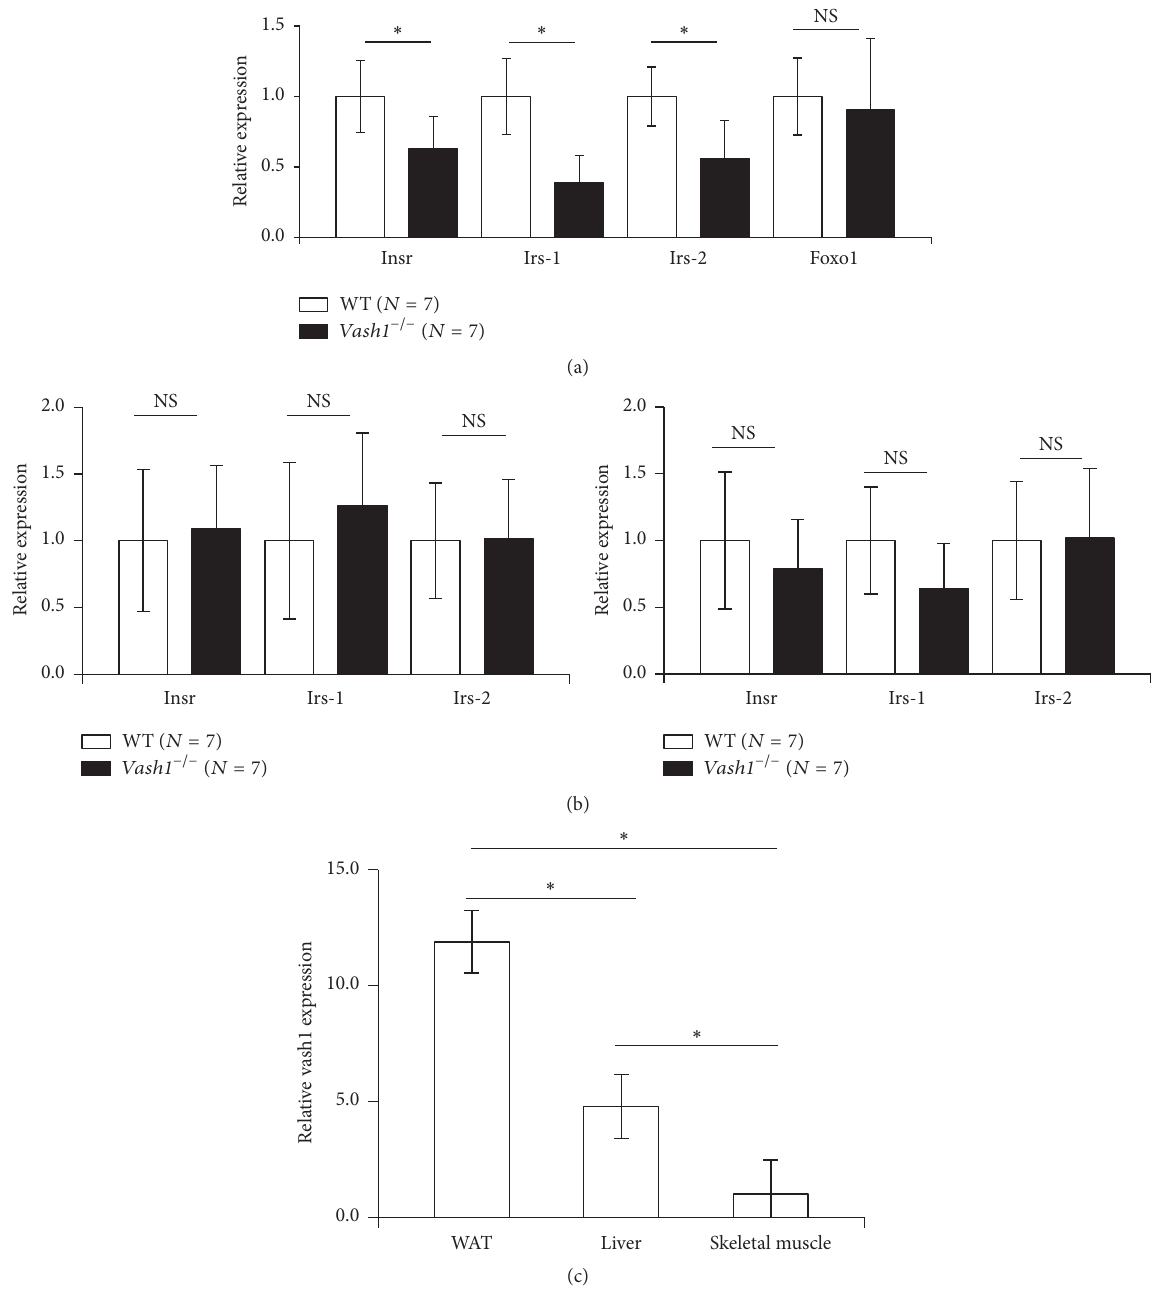
Figure 3: Downregulation of insr, irs-1, and irs-2 in WAT of young vash1 −/− mice. (a) Total RNA was isolated from the WAT of WT and vash1 −/− young male mice, and the expression of insr, irs-1, irs-2, and Foxo1 was compared between WT and vash1 −/− mice. (b) Total RNA was isolated from skeletal muscle or liver of WT and vash1 −/− young male mice; and the expression of insr, irs-1, and irs-2 was compared between WT and vash1 −/− mouse tissues. (c) Total RNA was isolated from WAT, liver, and skeletal muscle of young WT male mice, and the expression of vash1 was compared. In (a)–(c), the means ± SDs are shown, the statistical significance of differences was calculated by use of the unpaired Student’s 𝑡 -test, and a value of 𝑝 < 0.05 was the criterion for significance. ∗ 𝑝 < 0.05 .